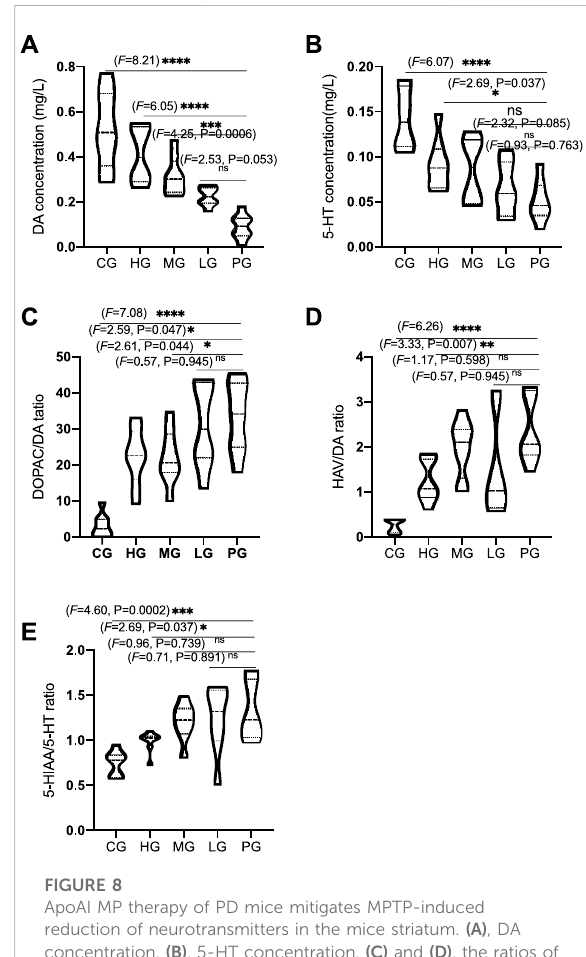
FIGURE 8 ApoAI MP therapy of PD mice mitigates MPTP-induced reduction of neurotransmitters in the mice striatum. (A) , DA concentration. (B) , 5-HT concentration. (C) and (D) , the ratios of DOPAC/DA and HVA/DA represent the levels of DA turnover. (E) , 5-HT turnover (the ratio of 5-HIAA/5-HT). N = 8 for in each group. ns P > 0.05, * p < 0.05, ** p < 0.01, *** p < 0.001 and **** p < 0.0001 vs. the PG